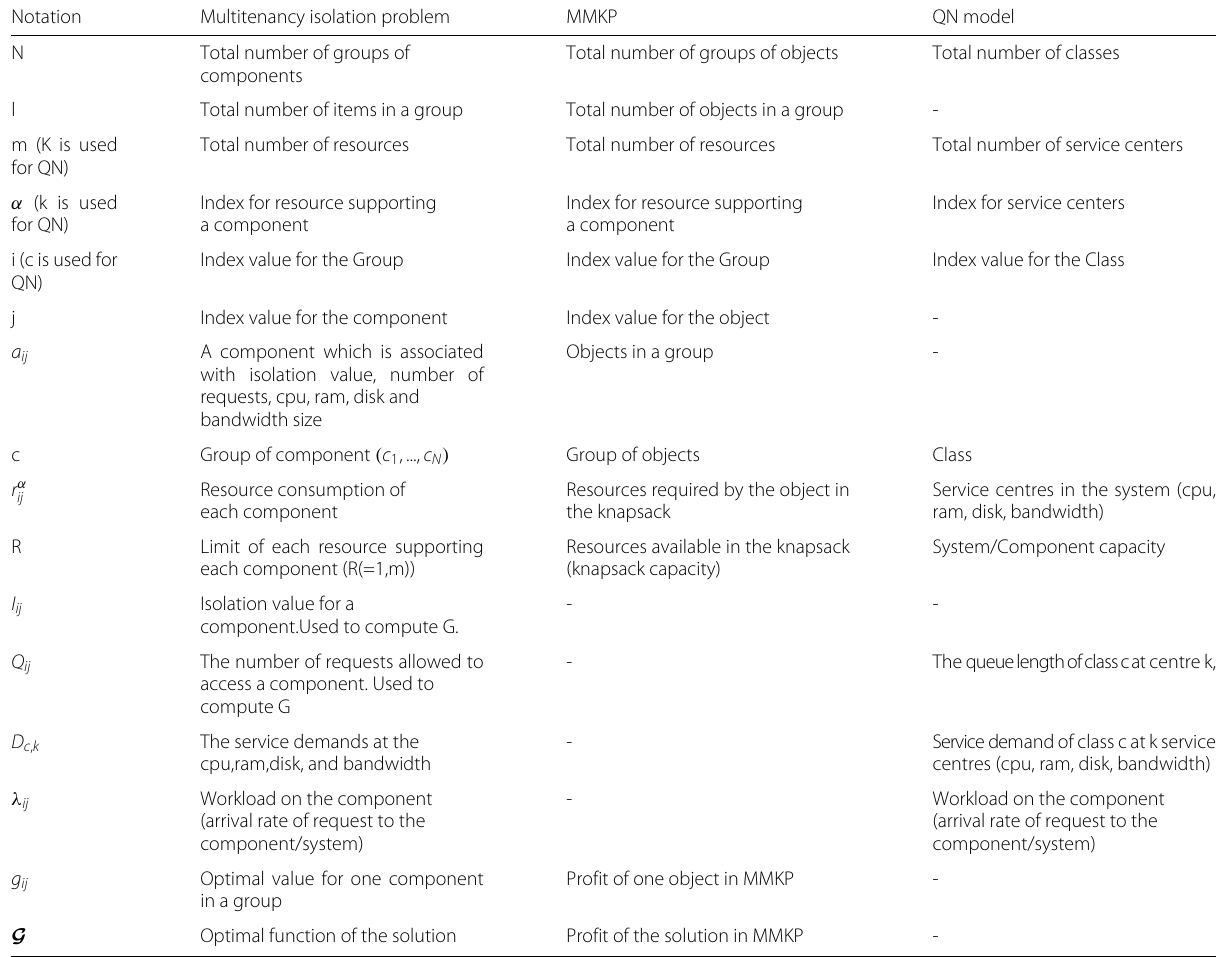
Table 1 Notations and mapping of multitenancy problem to QN model and